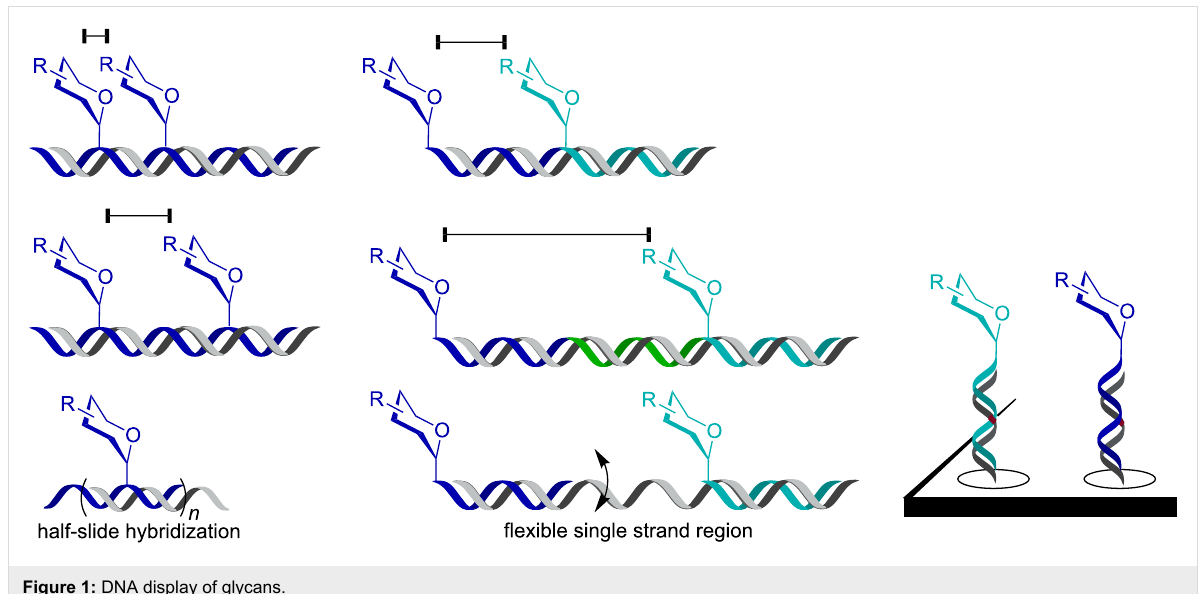
Figure 1: DNA display of